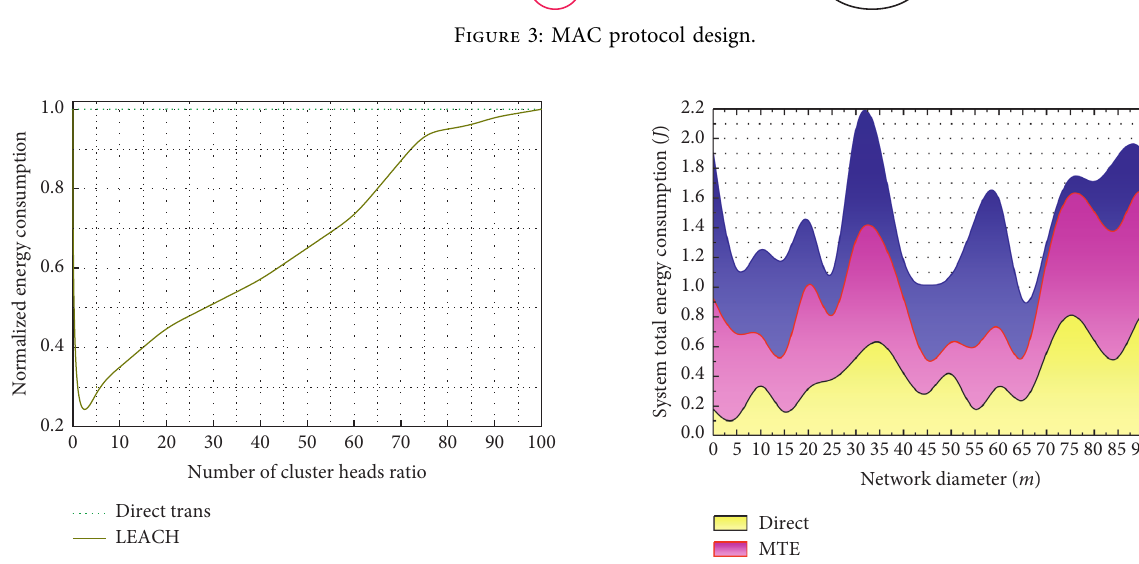
Figure 4: Relationship between system energy consumption and percentage of cluster headers. Figure